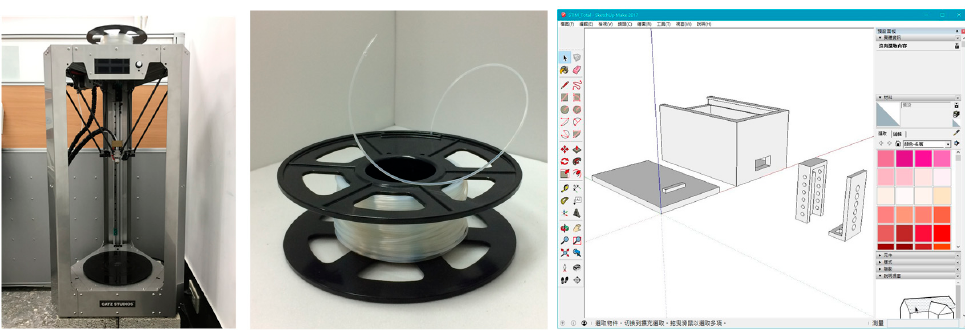
Figure 5. 3D printer, material and software.